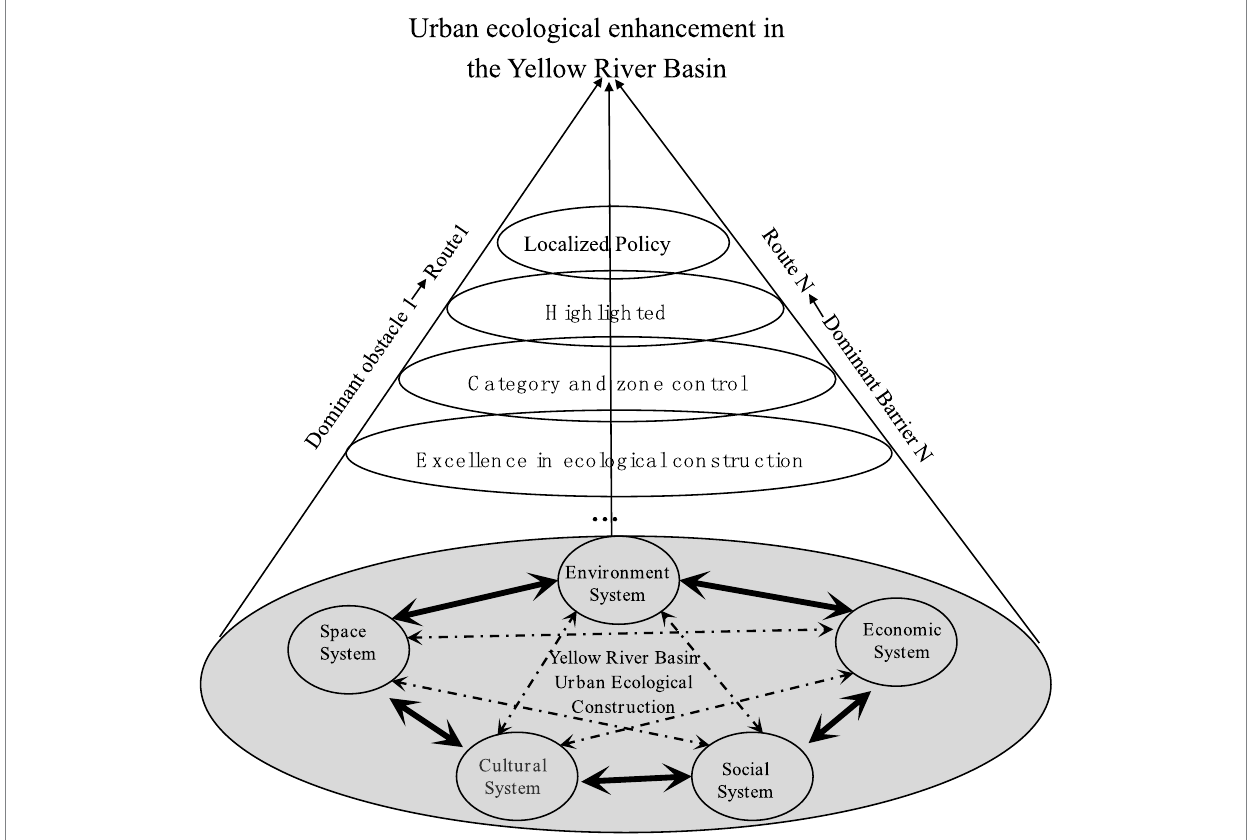
FIGURE 7 Suggested methods for improving quality of urban ecological construction in the Yellow River